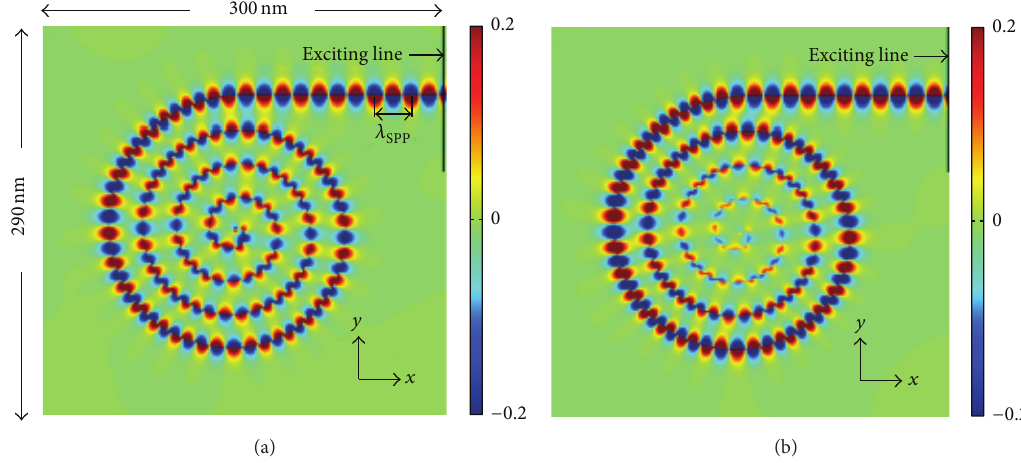
Figure 2: The normalized 𝐸 𝑦 component of guided SPPs along the spiral graphene waveguide at time 𝑡 = 1.9258 ps calculated by (a) conventional FDTD and (b) the proposed improved ADI-FDTD with CFLN = 10 [26].